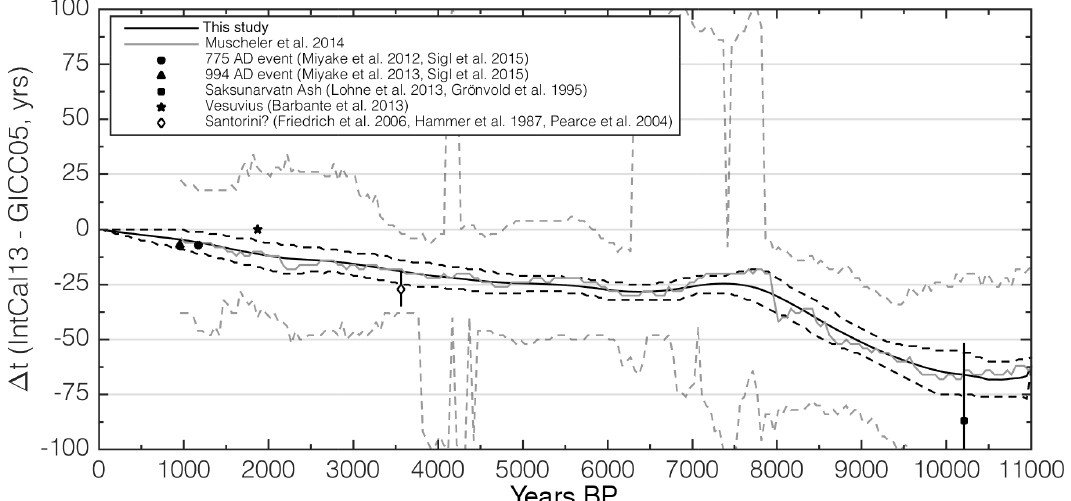
Figure 11. Comparison of the derived IntCal13-GICC05 timescale transfer function (black lines, this study) to the results by Muscheler et al. (2014a, grey lines), and independent age markers that have been linked independently to the IntCal13 and GICC05 timescales at high precision (symbols). The results of this study and Muscheler et al. (2014a) are shown with their respective 95% confidence intervals (dashed lines). The independent age markers are plotted as the difference between their estimated ages based on radiocarbon dating (Saksunarvatn Ash, Santorini), historical documents (Vesuvius) and dendrochronology (775 and 994 AD events), and their respective GICC05-ages. The plotted 1 σ error bars largely reflect uncertainties in the radiocarbon-dating and calibration of the Saksunarvatn Ash (Lohne et al., 2013) and the Santorini eruption (Friedrich et al., 2006). Note that the identification of the Santorini tephra in ice cores has been challenged based on its geochemistry (Pearce et al.,